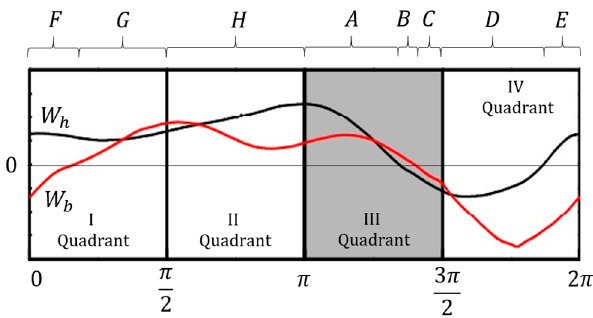
Figure 1. Rectangular coordinate showing pump operation zones and